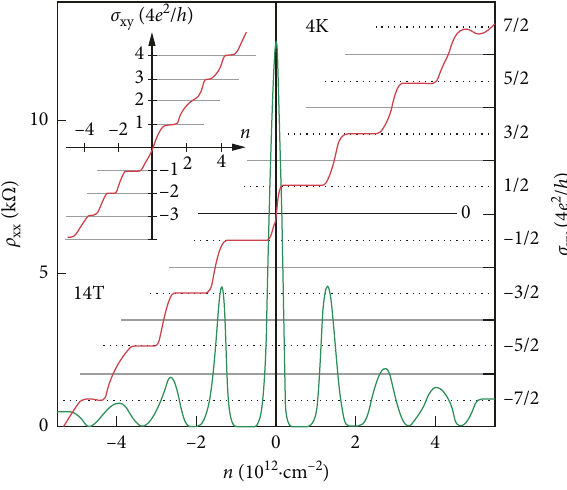
Figure 17: Single-layer graphene with quantum Hall effect